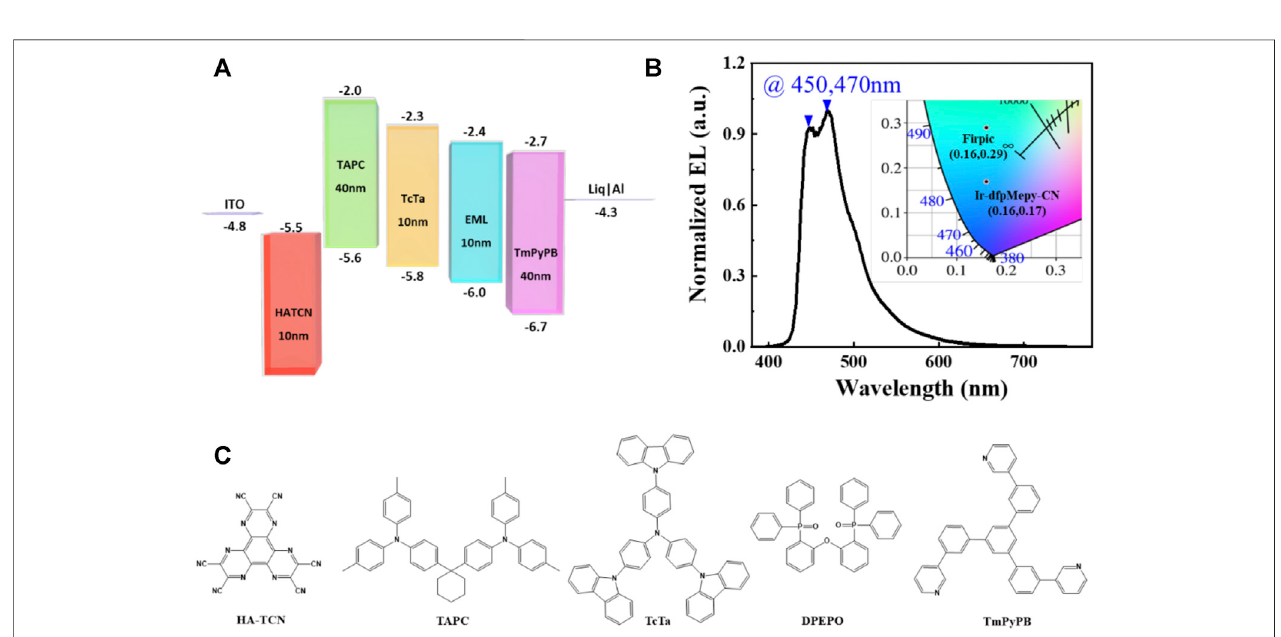
FIGURE4|(A) Thedevicestructureand (B) electroluminescence(EL)spectraat5 VofOLEDfabricated with Ir-dfpMepy-CN asdopant(insert:CIEcoordinateof FIrpic and Ir-dfpMepy-CN ) (C) materials used for device fabrication. HOMOs keep synergistically. The N-heterocyclic phenyl unit in dfpMepy almost dominates LUMO and LUMO+1. The T 1 optical transition state were calculated by TD-DFT. As shown in